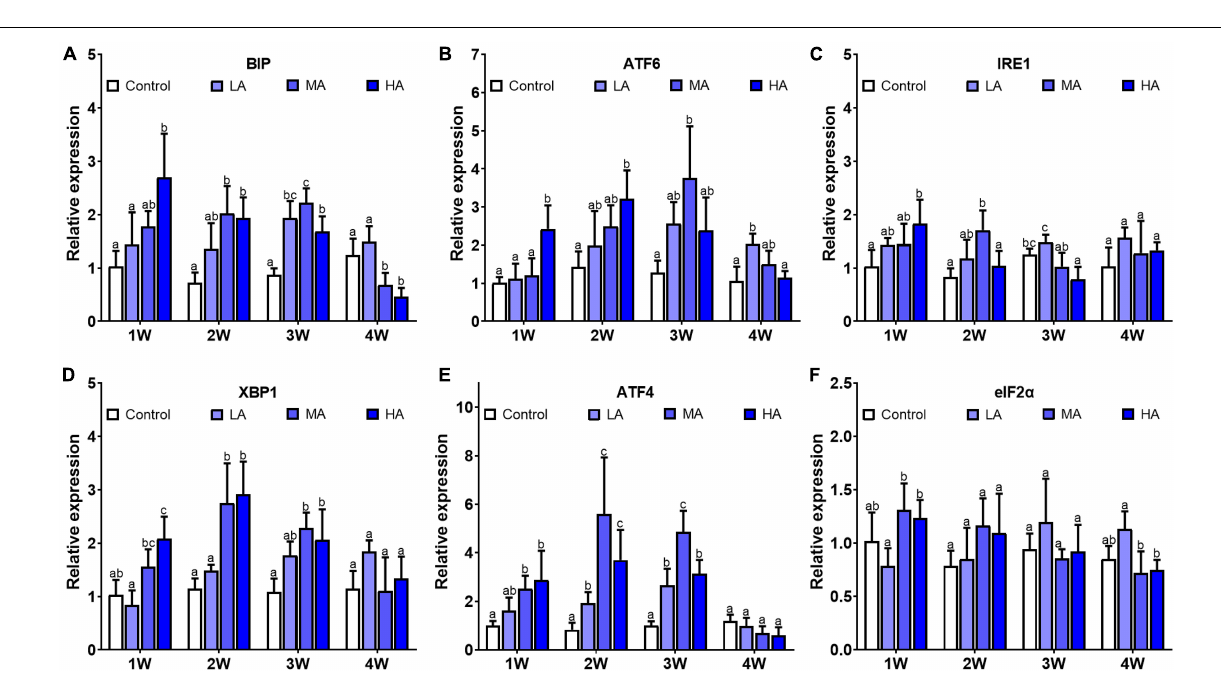
Frontiers in Marine Science |